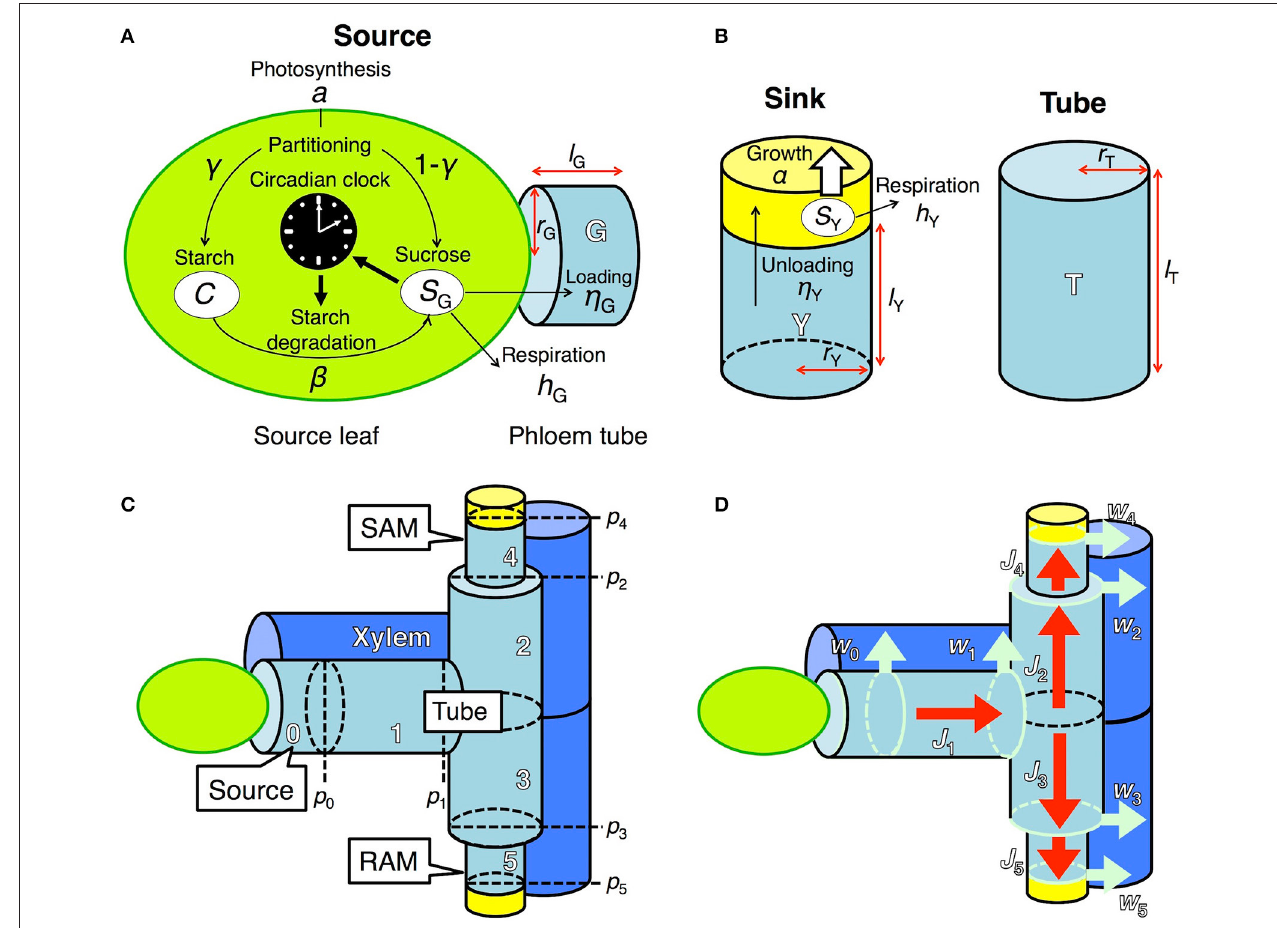
FIGURE 1 | Model describing sugar dynamics in source and sink tissues and translocation of sucrose through the phloem tube. (A) In a source leaf, the circadian clock and carbon metabolism are reciprocally regulated. (B) Translocated sucrose is used for growth and respiration in the sink. Each structural component is expressed by a cylinder of radius r X and height l X , where X is either G (source), T (tube), or Y (sink). (C) Tubal structure of the model. p i represents hydrostatic pressure at the apex of component i ( i ǫ {0,…, 5}). Xylem adjacent to the phloem tube is also schematized. SAM, shoot apical meristem; RAM, root apical meristem. (D) Fluxes in the model. Red arrows ( J i ) indicate phloem sap flow. Light blue arrows ( w i ) indicate pure water flow due to osmosis, which occurs at the region represented by light blue